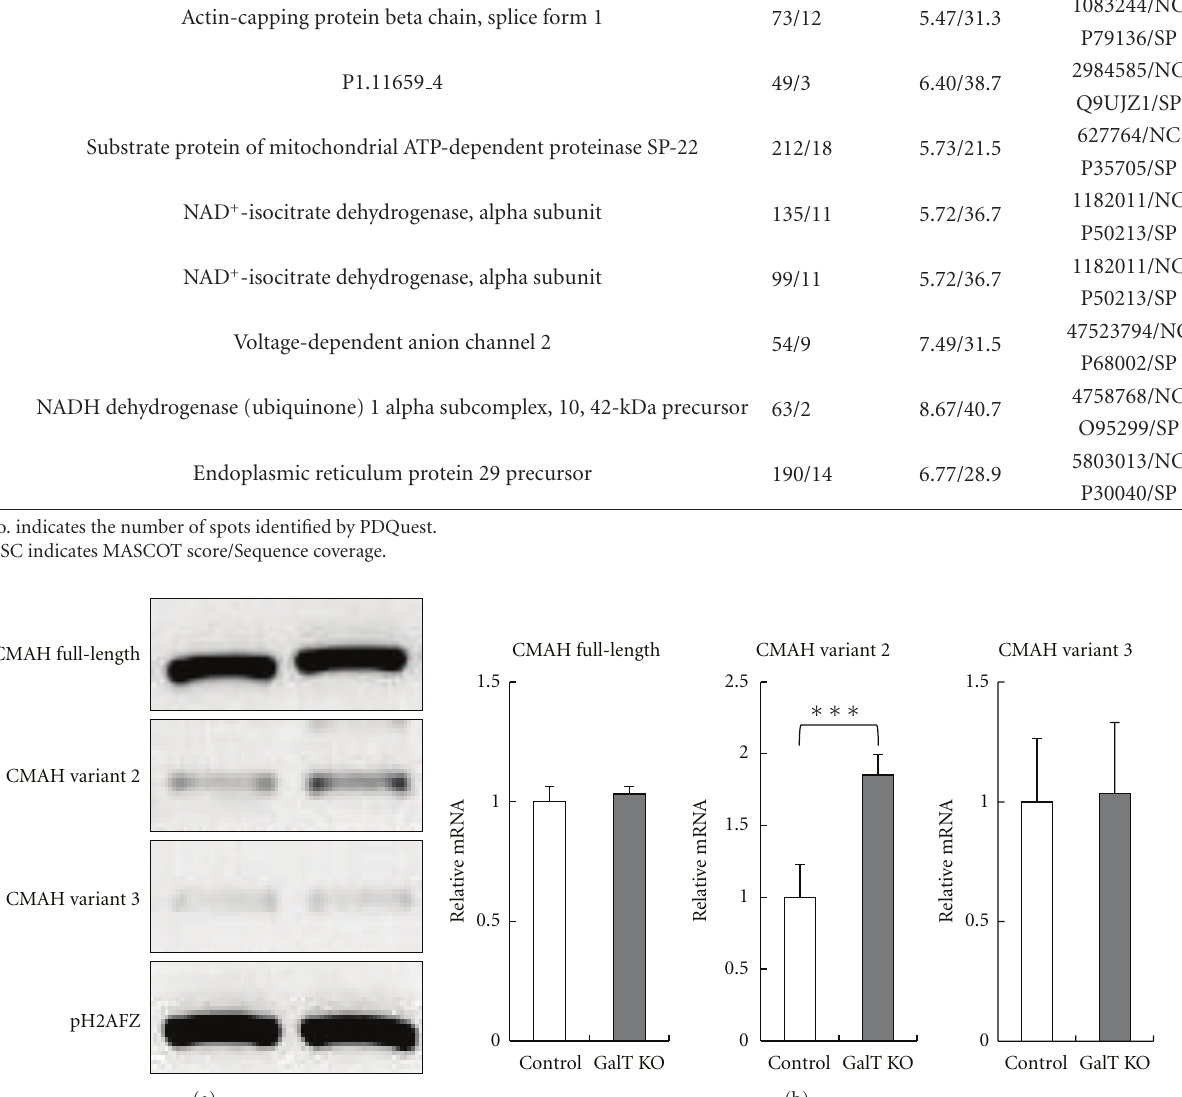
Figure 3: Expression of full-length CMAH and variants in control and heterozygote α 1,3-galactosyltransferase gene (GGTA1) knockout (GalT KO) liver. (a) Electrophoretic analysis of real-time reverse transcriptase-polymerase chain reaction (RT-PCR) in control and heterozygote GalT KO liver. (b) Quantification of real-time RT-PCR analysis in control and heterozygote GalT KO liver. All RT-PCR reactions were conducted in triplicate and normalized for pig H2A histone family, member Z gene (pH2AFZ). Each of the GalT KO relative values is presented as an n-fold expression di ff erence compared to the control, which was set as 1. ∗∗∗ P < 0 .